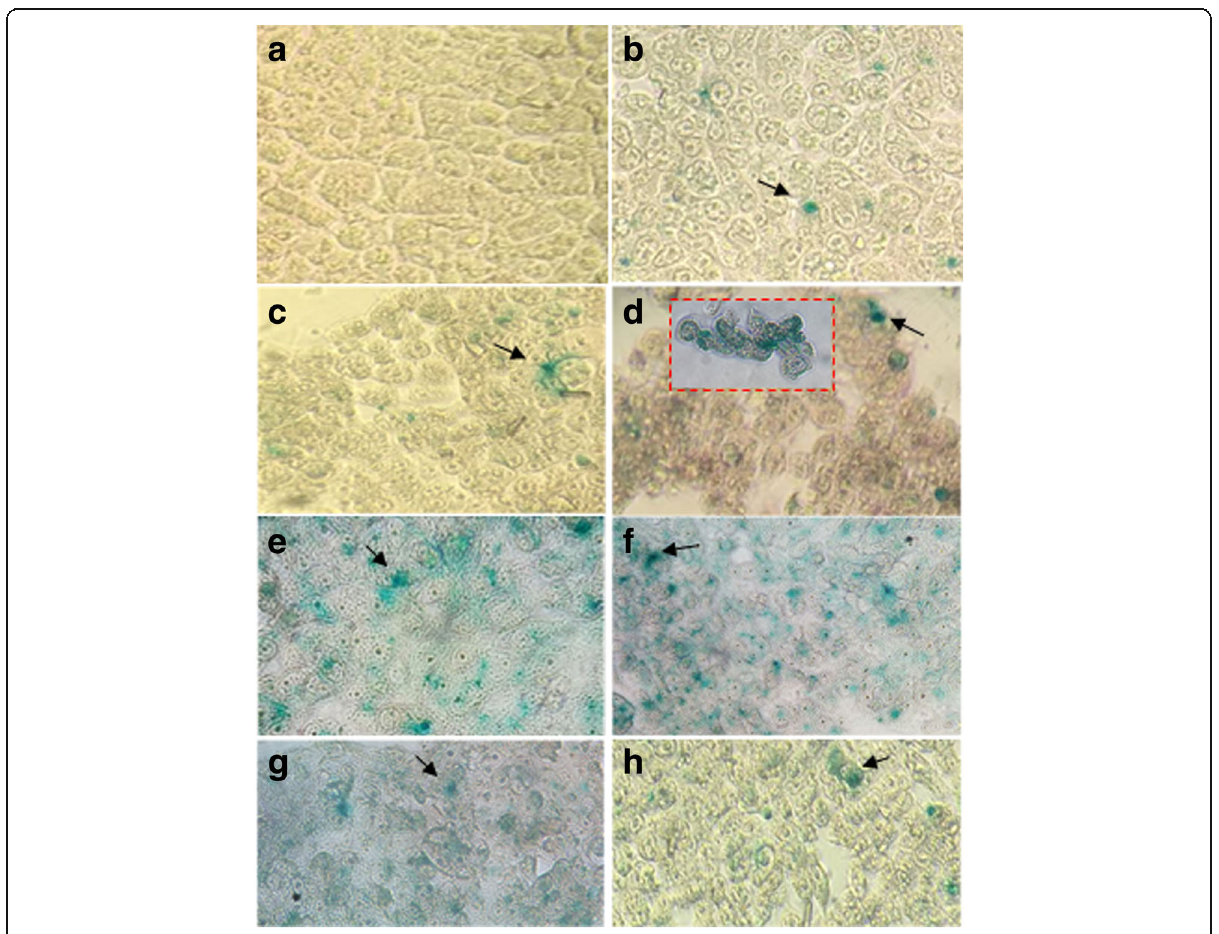
Fig. 8 HEK-293 Homo sapiens (human)-epithelial morphology-embryonic kidney-fetus cell transfection tests (pSV- β -Gal). a HEK-293 cells, b positive control: LipofectAMINE TM 2000, c CO-AuNP, d Acyl-CO-AuNPs, e COS@1-AuNPs, f COS@2-AuNPs, g COS@3-AuNPs, and h COS@4-AuNPs. Arrows point to transfected